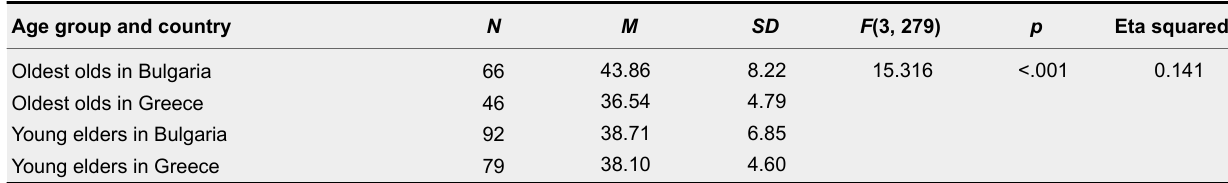
Age Differences in Sentimentality and Nostalgia Between the Elderly People in Bulgaria and Greece Age group and country N M SD F (3, 279) p Eta squared Oldest olds in Bulgaria 66 Oldest olds in Greece Young elders in